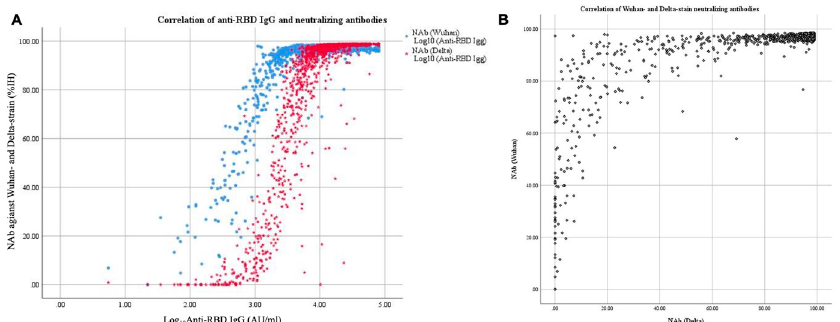
Figure 4. Correlations of antibody responses of post-SARS-CoV-2 infected participants (600 partici- pants with 1126 blood samples). ( A ) Between anti-RBD IgG and neutralizing antibodies against Wu- han and Delta strains; ( B ) Between neutralizing antibodies against Wuhan and Delta strains.